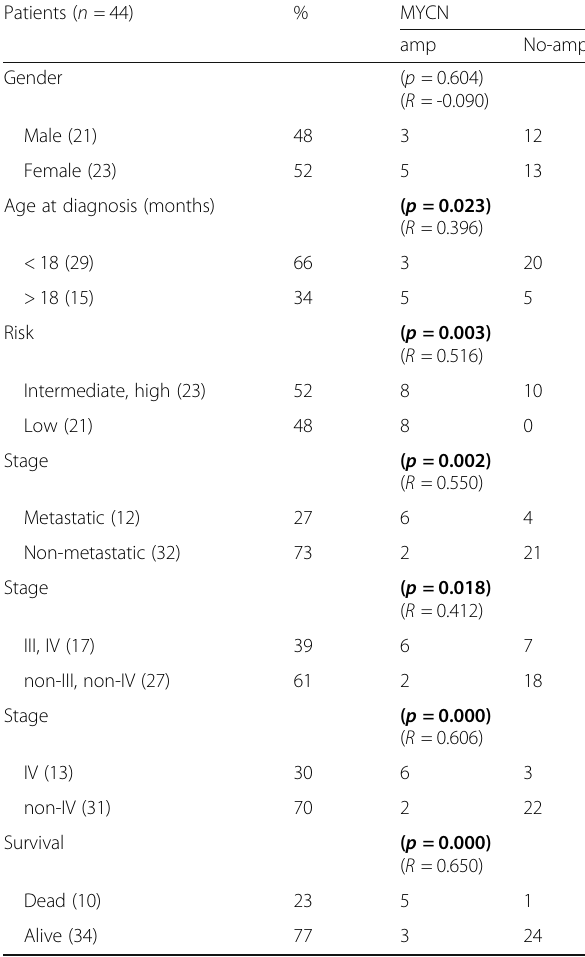
Table 1 Clinic-pathologic characteristics and MYCN amplification of study